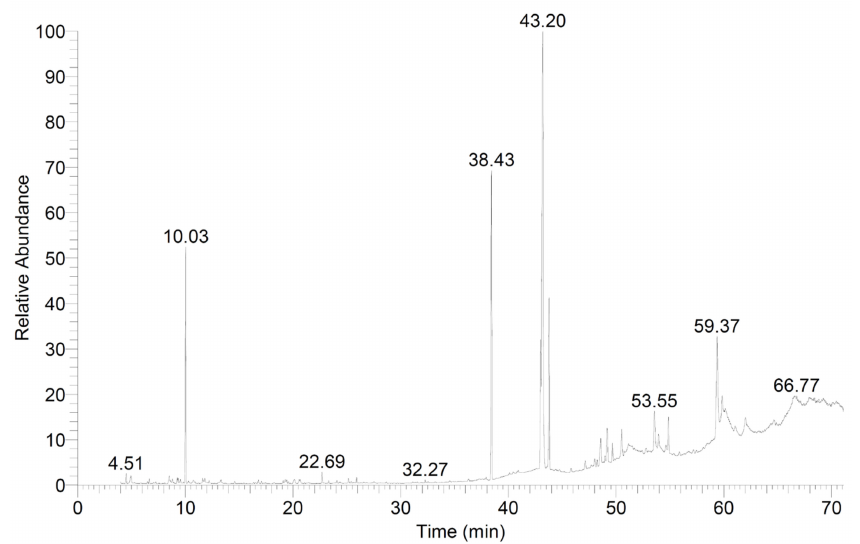
Figure 6. GC/MS graph for biodiesel analysis produced from transesterification/esterification process of waste cooking oils by immobilized